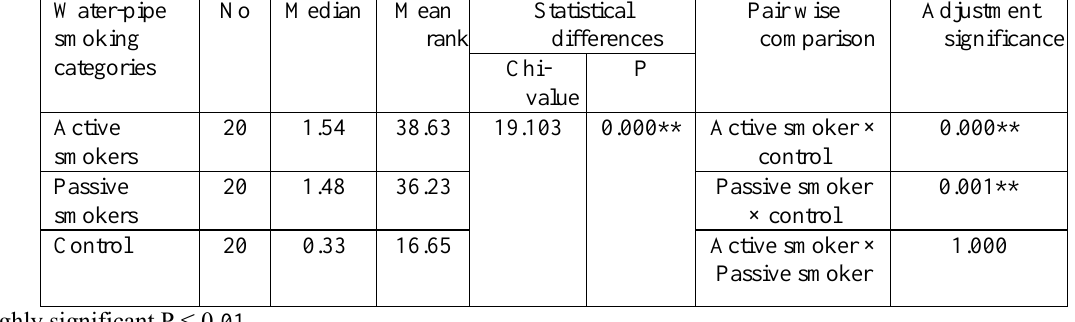
Table 3: Gingival index (Median, Mean Rank) among water-pipe smokers in comparison to control group with statistical difference.